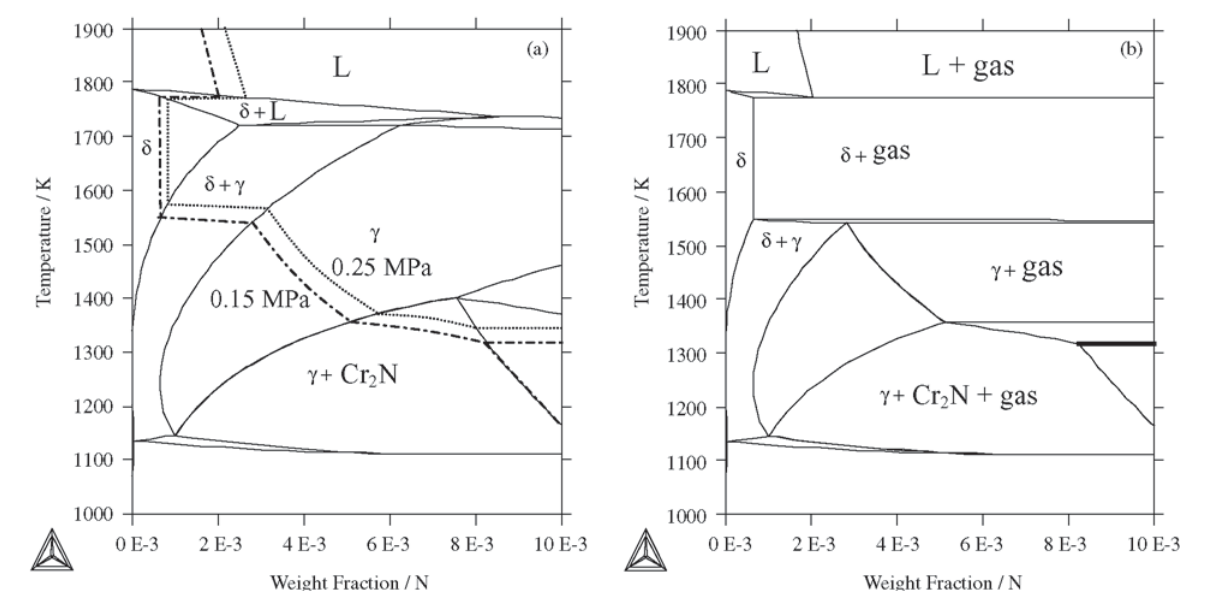
Figure 1. Fe – 13% Cr – N isopleths a) not considering the gas phase as an equilibrium one, with N N gas phase as an equilibrium 2